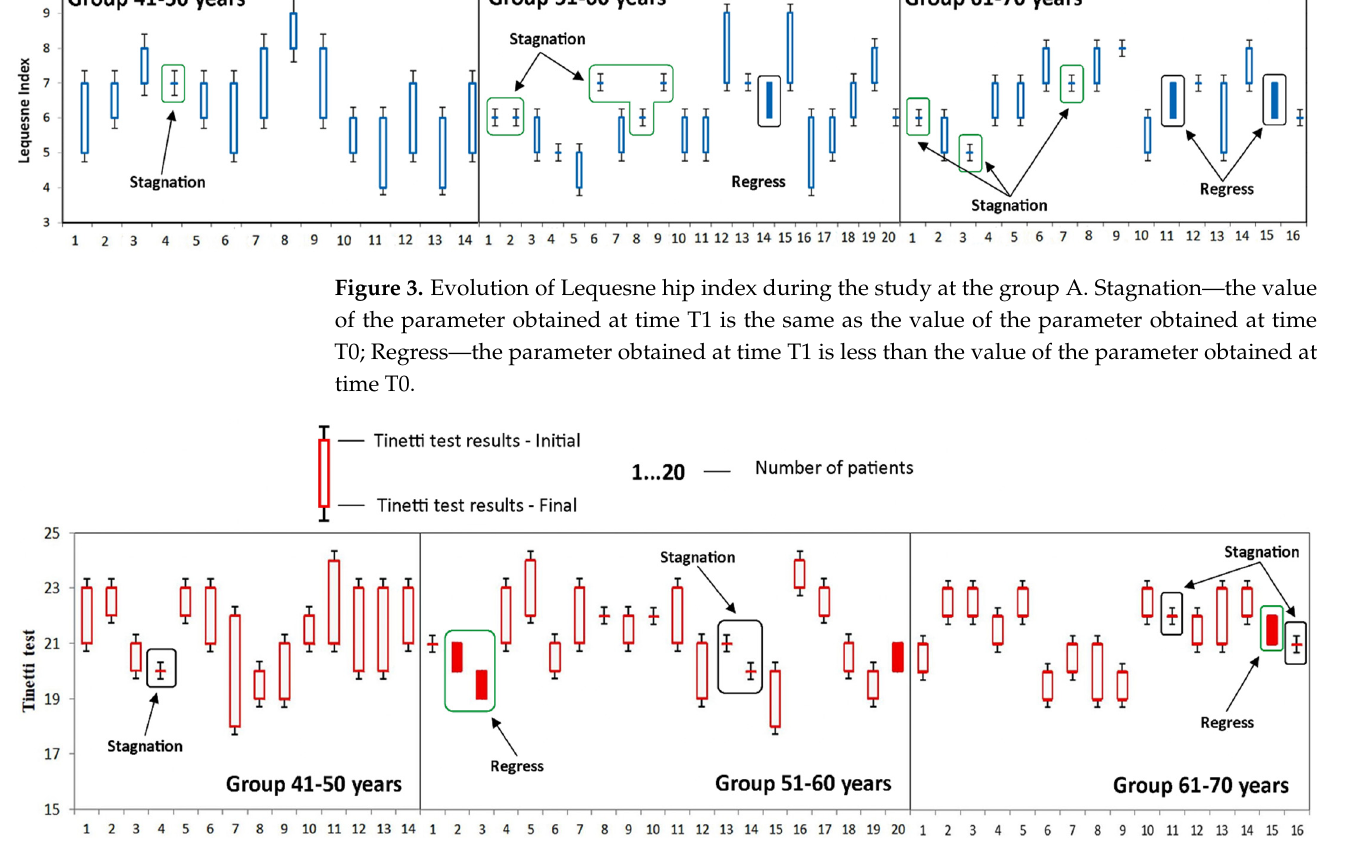
Figure 4. Evolution of Tinetti test during the study at the group A. Stagnation—the value of the parameter obtained at time T1 is the same as the value of the parameter obtained at time T0; Regress—the parameter obtained at time T1 is less than the value of the parameter obtained at time T0.